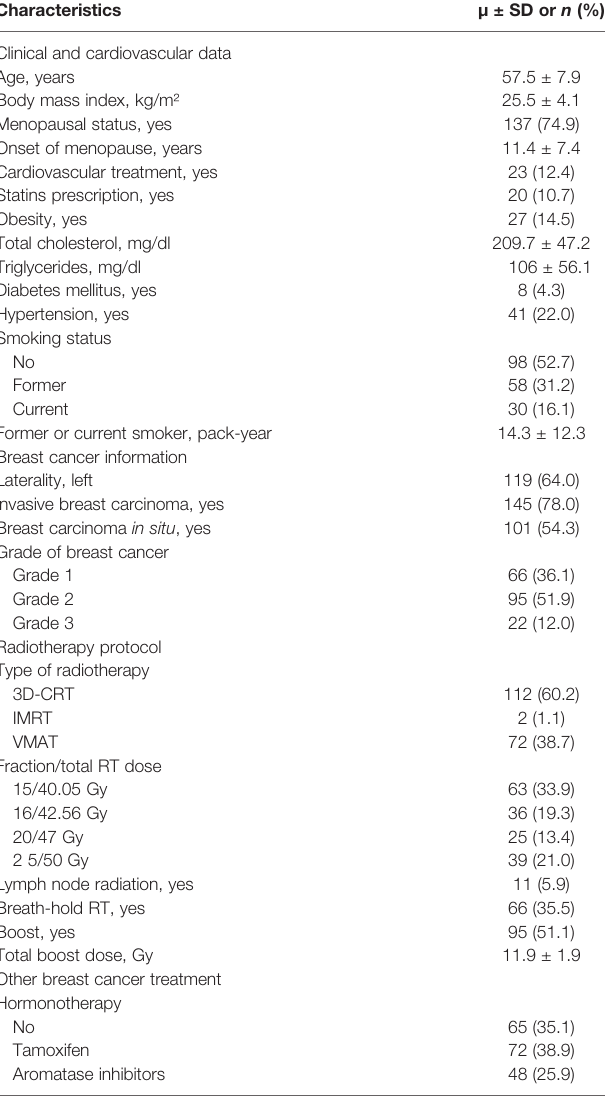
TABLE 1 | Baseline characteristics of the 186 BC women from the EARLY ‐ HEART cohort included in the echocardiography-based analysis. Characteristics